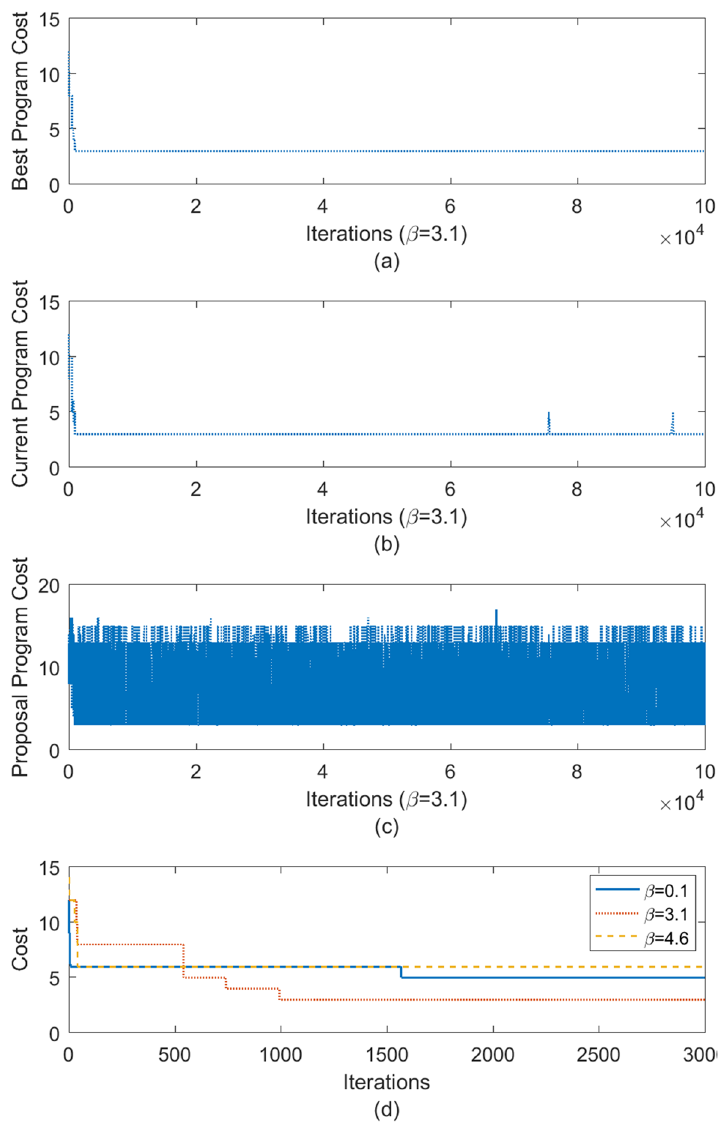
Figure 4. Parameter fine-tuning using Bayesian optimization. We use Bayesian optimization to auto-tune parameters such as β and probabilities as they determine the performance of a synthesizer. We find out that β = 3.1 is a better choice compared to β = 0.1 and 4.6. ( a – c ) show the best, current, and proposal